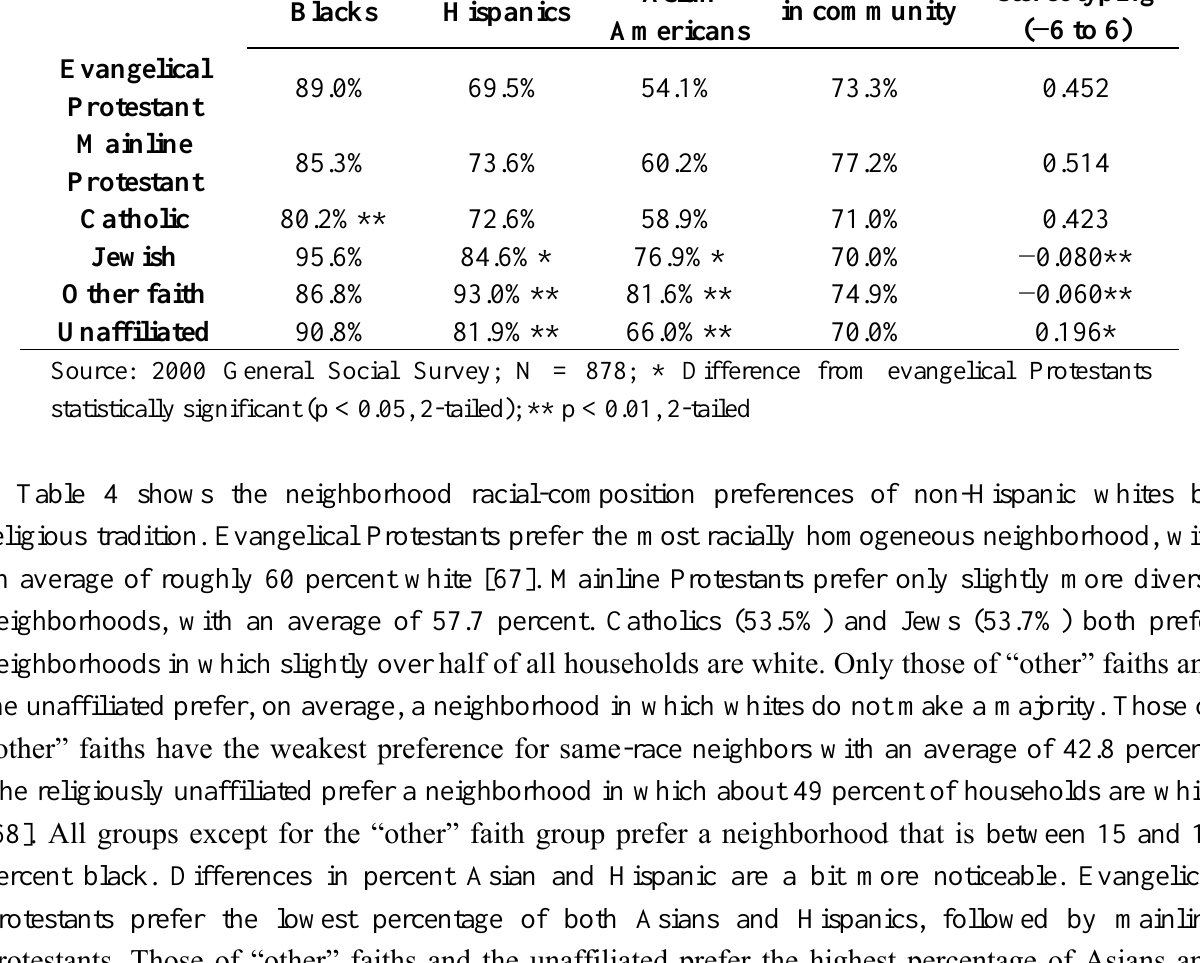
Table 3. Comparison of Evangelical Protestants to Other Groups on Key Independent Variables. “Personally knows”: Racial Percent white stereotyping Asian in community Blacks Hispanics (−6 to 6)